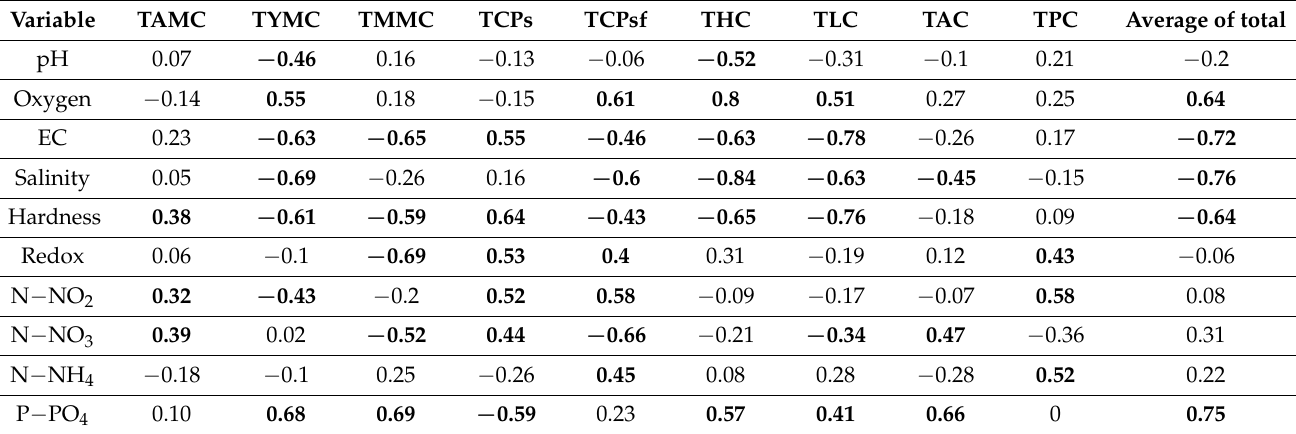
Table 4. Correlation matrix between physicochemical parameters of the ballast water and the microbiota.